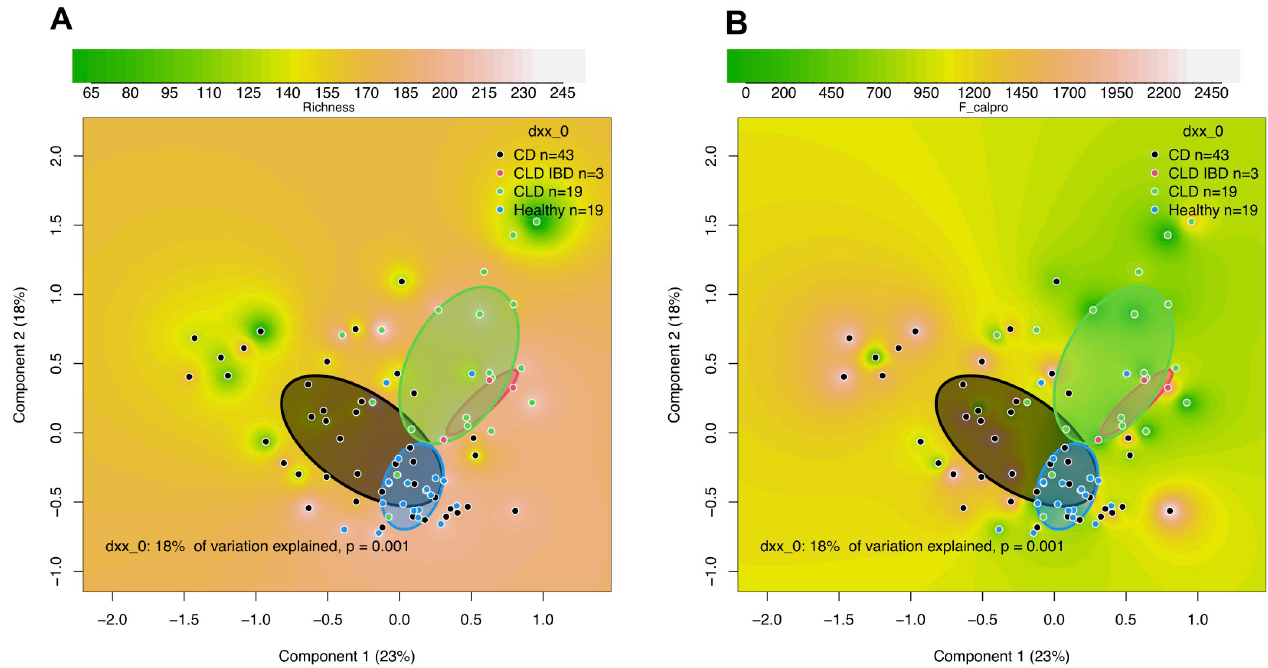
Fig 2. Comparison of fecal microbiota in congenital chloride diarrhea (CLD), CLD-associated inflammatory bowel disease (CLD IBD), Crohn’s disease (CD), and healthy controls. Shown are Principal-coordinate Analysis (PcoA) plots based on Bray-Curtis dissimilarities of the samples, showing as background (A) richness of the microbiota and (B) fecal calprotectin levels for the samples. The units of richness in PcoA plots are arbitrary. Clusters are shown by circles, which were drawn based on the standard deviations of the data points in each category of the samples (CD, CLD IBD, CLD, Healthy).